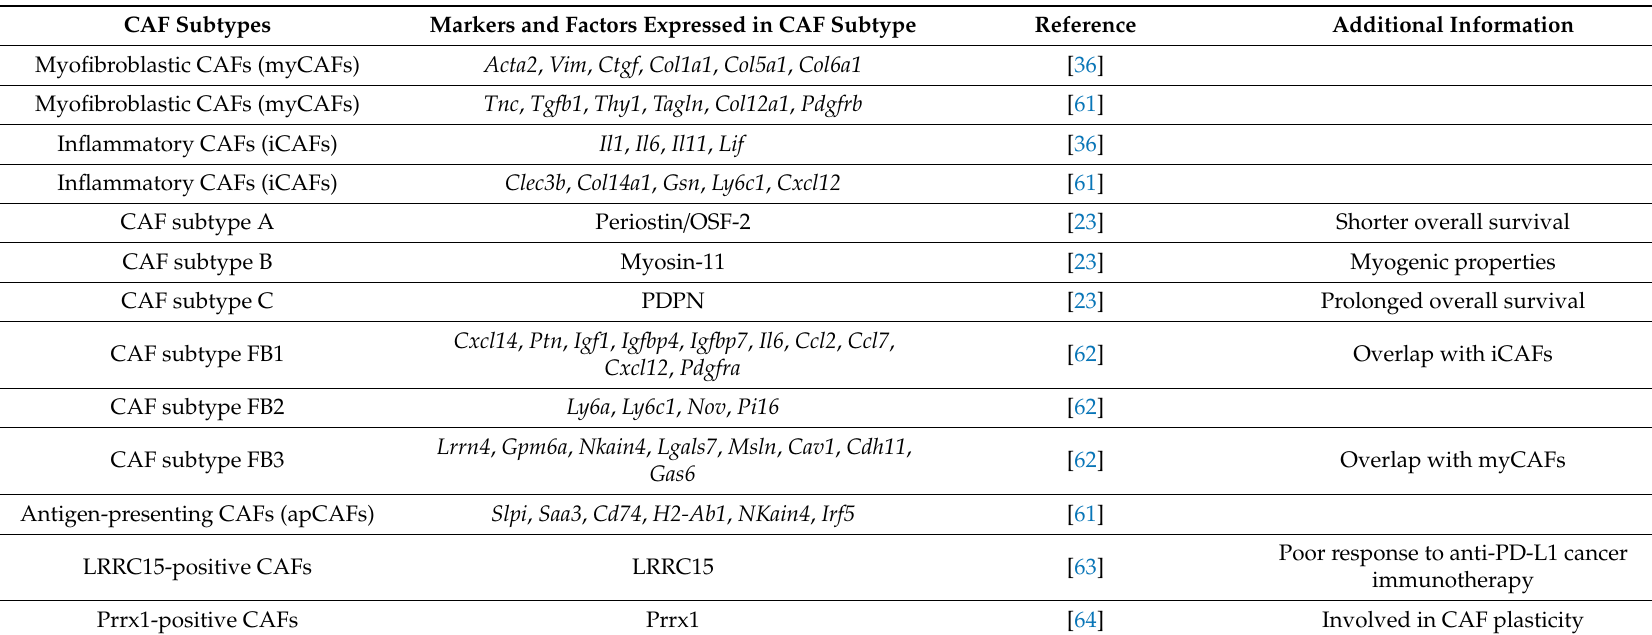
Table 3. Cancer-associated fibroblast (CAF) subtypes and CAF-subtype-defined